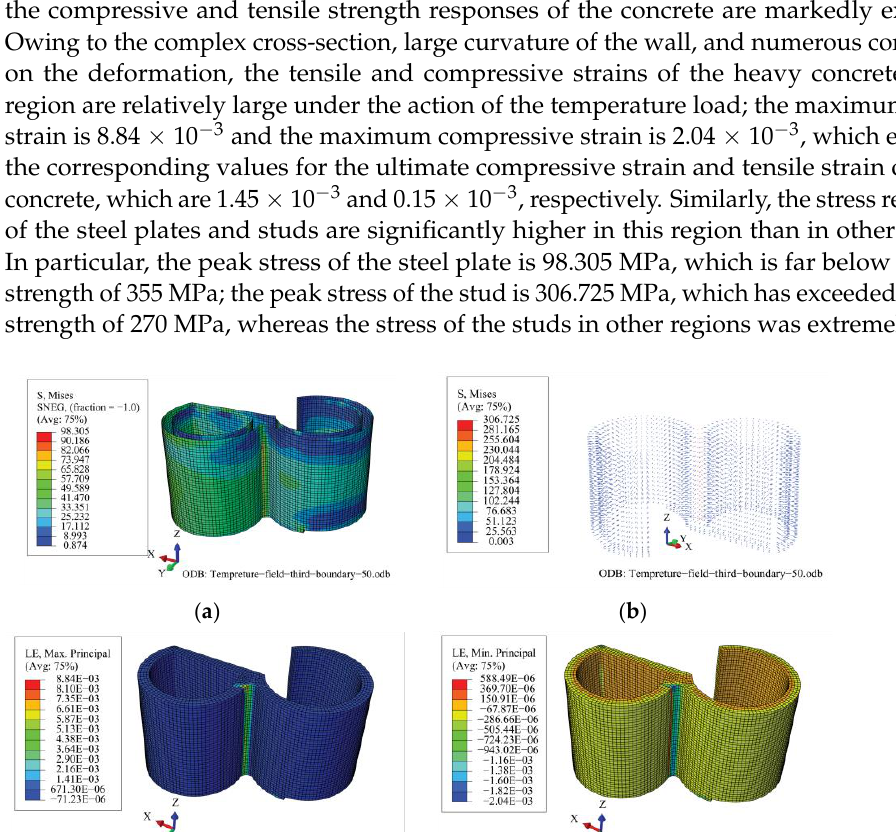
Figure 4. The temperature field of the internal concrete under normal operation.